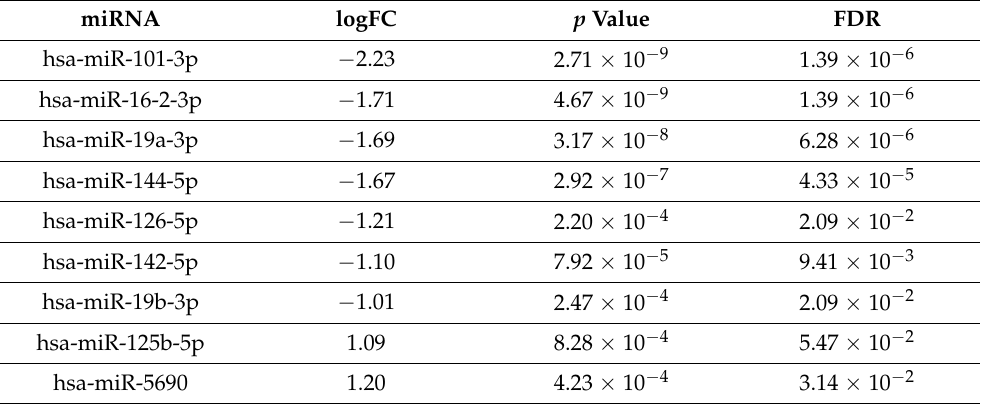
Table 1. miRNAs identified as differentially expressed by RNA-seq analysis in frail vs. robust patients. miRNA logFC p Value FDR hsa-miR-101-3p −